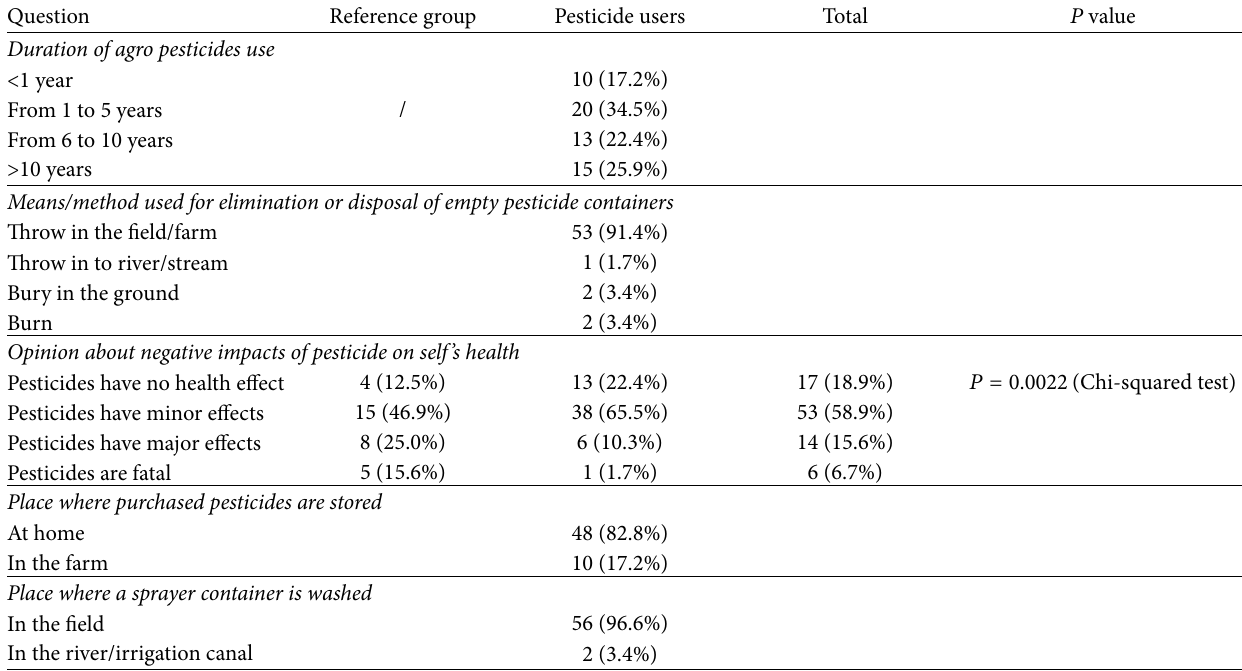
Table 2: Duration of pesticide use, storage and awareness on